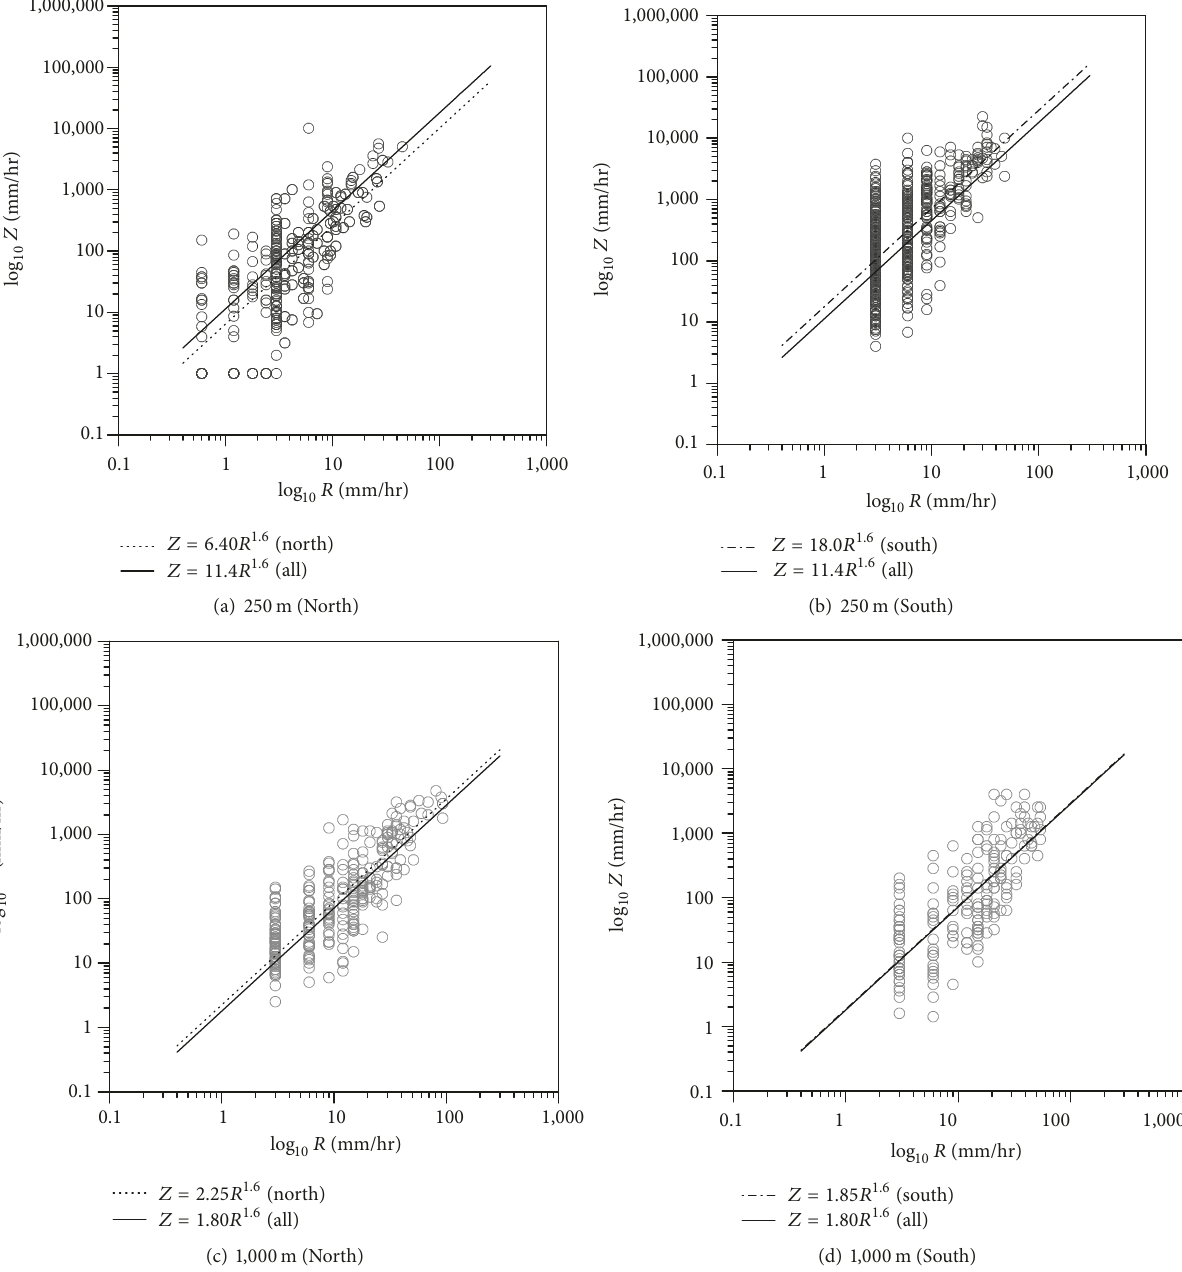
Figure 9: Comparison of the 𝑍 - 𝑅 relationships derived for northern and southern parts of the Jeju Island. In this figure, the solid line represents the 𝑍 - 𝑅 relationship derived using all the data available and the dotted lines for northern and southern parts